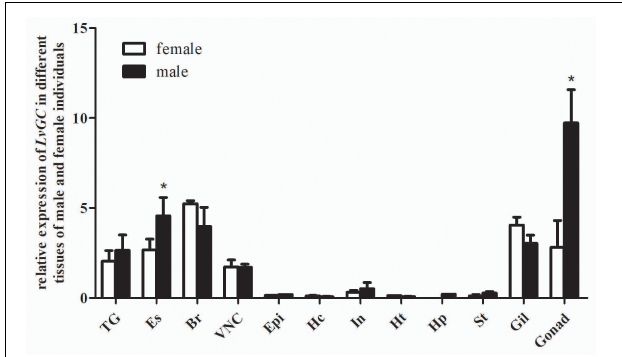
FIGURE 6 | Distribution of LvGC in different tissues of male and female L. vannamei . 18S rRNA gene was used as the internal reference. TG, thoracic ganglia; Es, eyestalk; Br, brain; VNC, ventral nerve cord; Epi, epidermis; Hc, hemocyte; In, intestine; Ht, heart; Hp, hepatopancreas; St, stomach; Gil, gill; Ov, ovary; Te, testis. Expression levels of target genes were detected in three replicates for each tissue. Significant differences ( P < 0.05) of LvGC expression in male and female tissues were shown with stars ( ∗